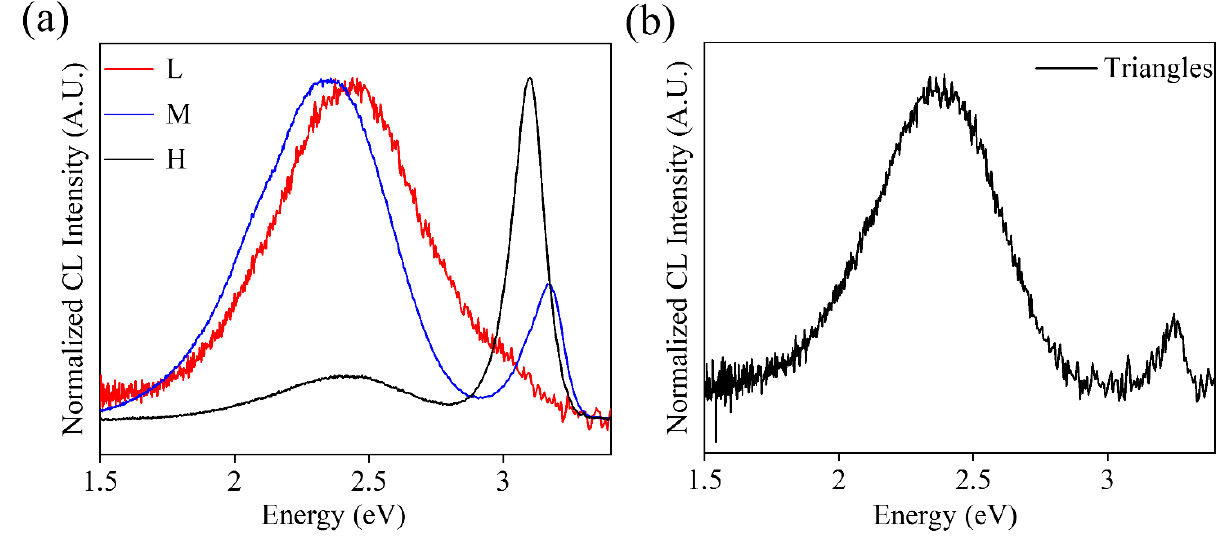
Figure 9. ( a ) CL spectra of elongated structures of L-M-H samples. ( b ) CL spectrum on a structure of triangles.